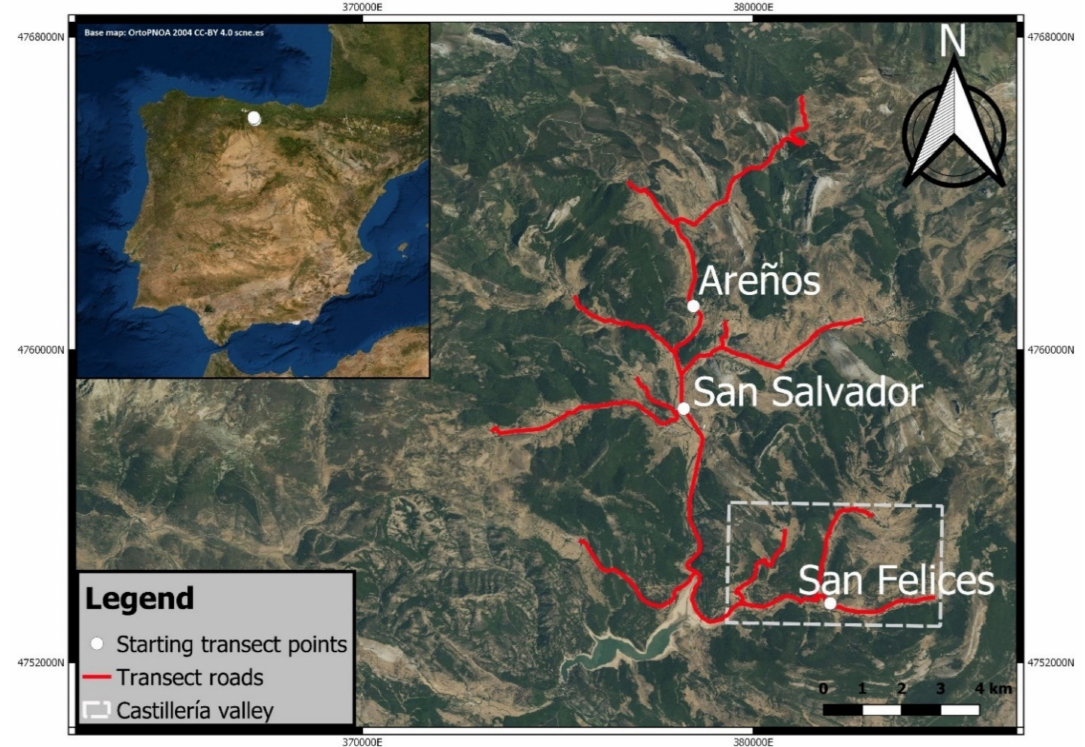
Figure 1. Map of the study area in La Pern í a Valley (Palencia, Spain), with transect for censusing carnivores (red line), and the three starting points for censuses (see Materials and Methods for